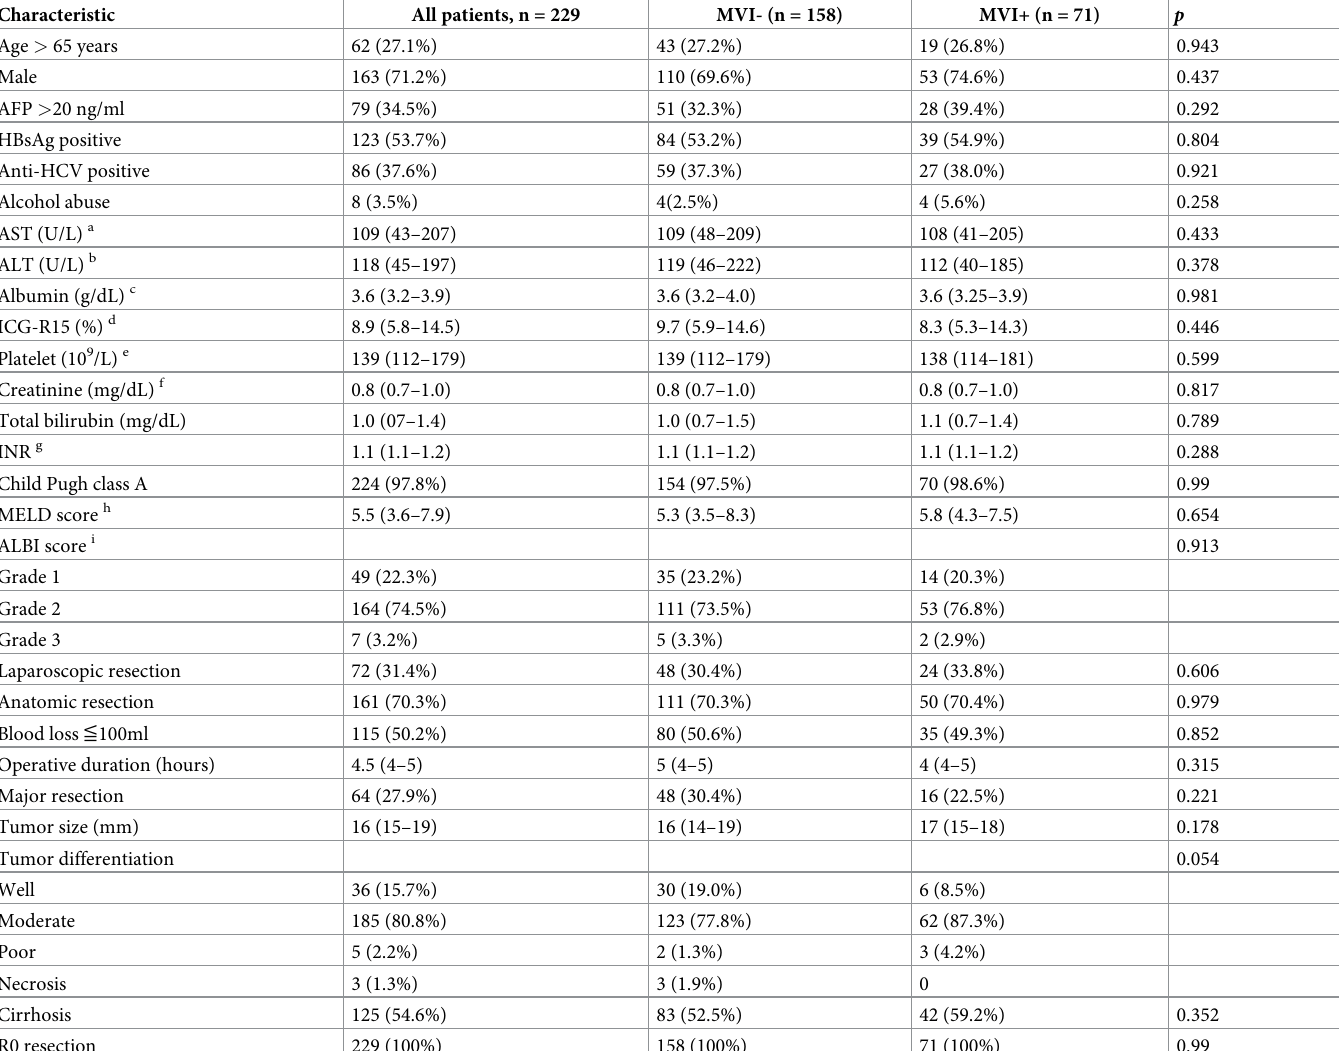
Table 1. Characteristics of patients with HCC up to 2 cm by microvascular invasion